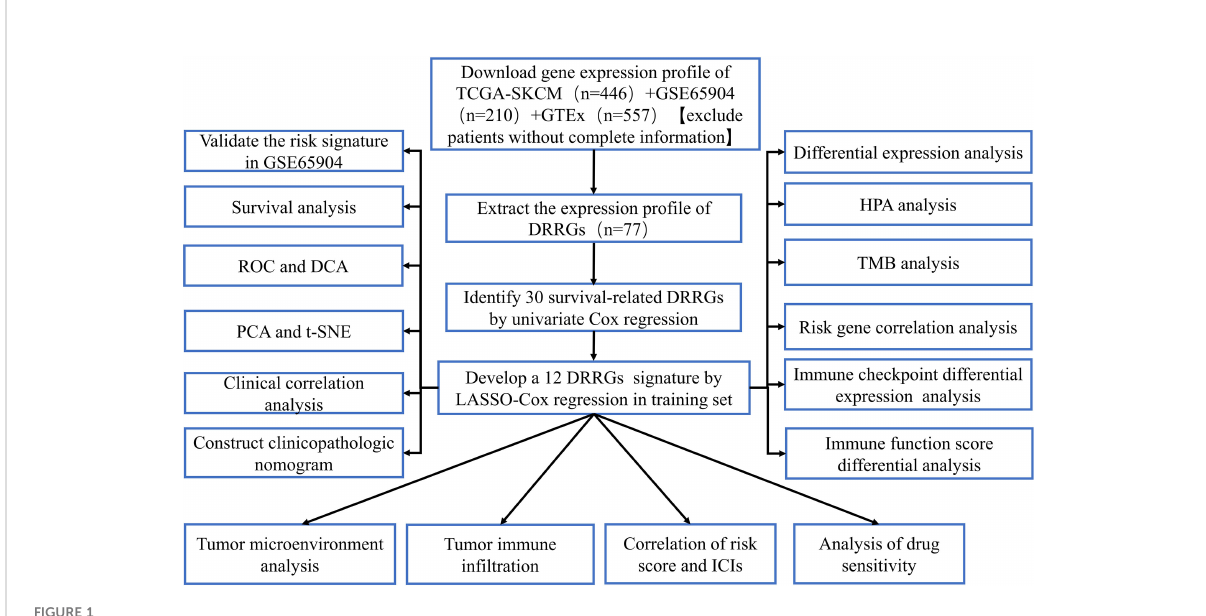
FIGURE 1 The fl ow diagram of this